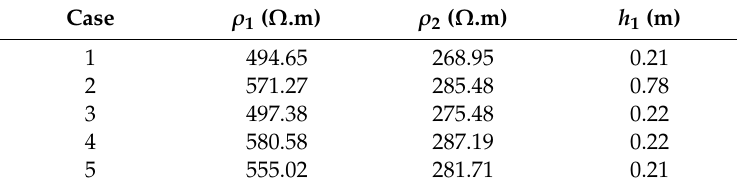
Table 2. Two-layer soil model parameters for the five combinations of resistivity measuring axes.